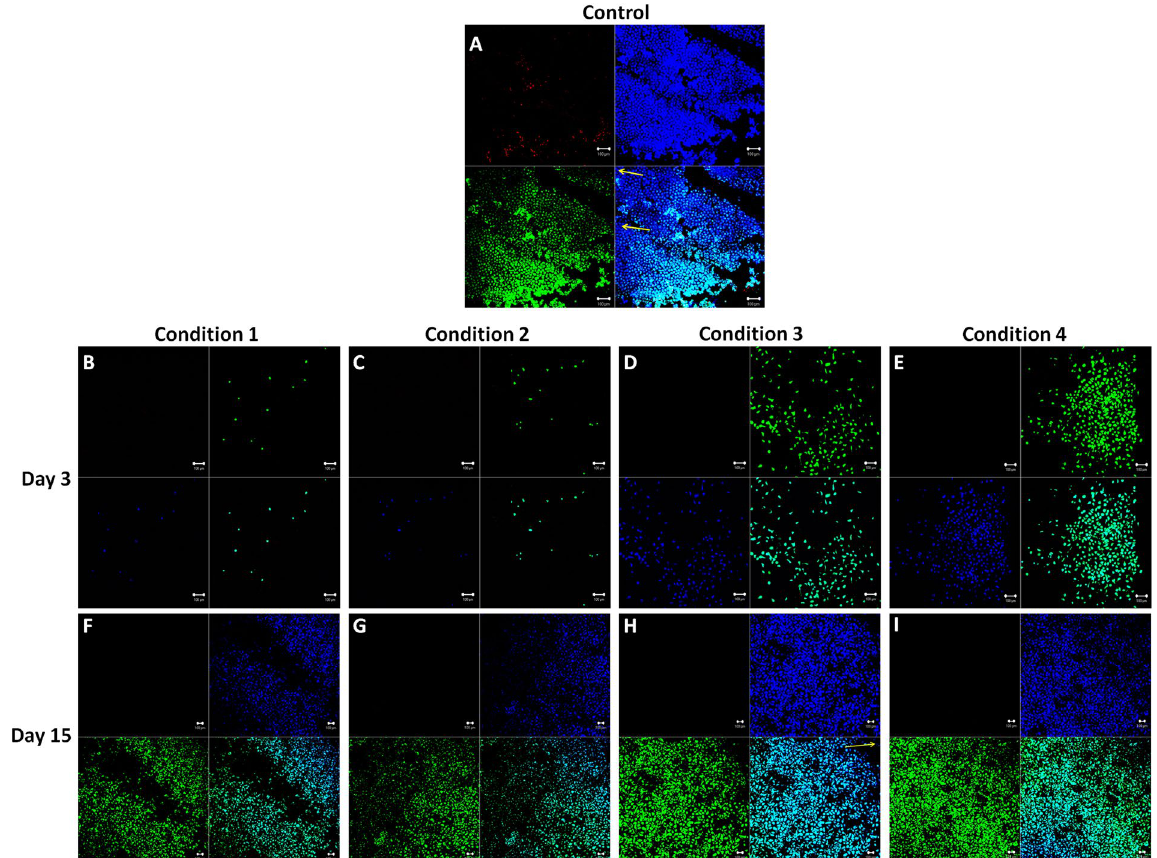
Figure 3. HEC staining to determine live/dead/apoptotic cells. ( A ) Control cornea to show the presence of dead (red), live (green), apoptotic (blue without green marked with yellow arrow) and nucleus (blue). ( B – E ) At day 3, higher number of cells was observed in C3 and C4 compared to C1 and C2 without any dead or apoptotic cells. F-I) at day 15 confluence of viable cells was observed in C3 and C4 compared to C1 and C2. Scale bar = 100 µ